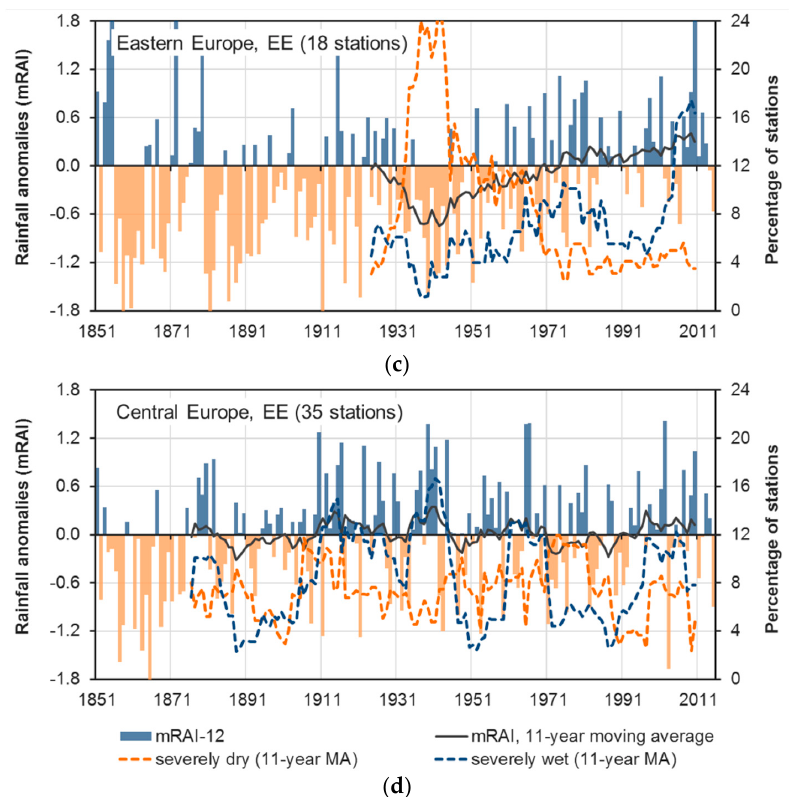
Figure A1. Time series of annual precipitation anomalies as well as the percentage of stations under severely dry and wet conditions, respectively, for the regions ( a ) BI, ( b ) SC, ( c ) EE, and ( d ) CE; 1851–2015.